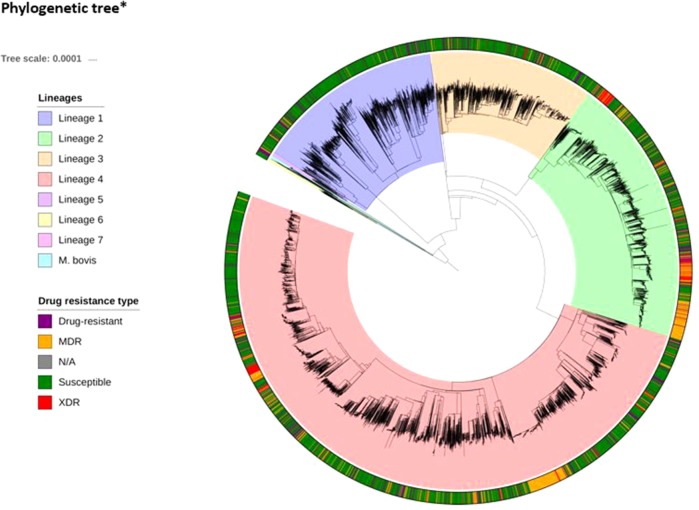
Phylogenetic tree*(attached as separate file)* The tree includes all 16,688 isolates, complemented by additional data from lineages 5–7 and M. bovis. The tree was fitted using a maximum likelihood approach implemented in RAxML (Stamakis, 2014).